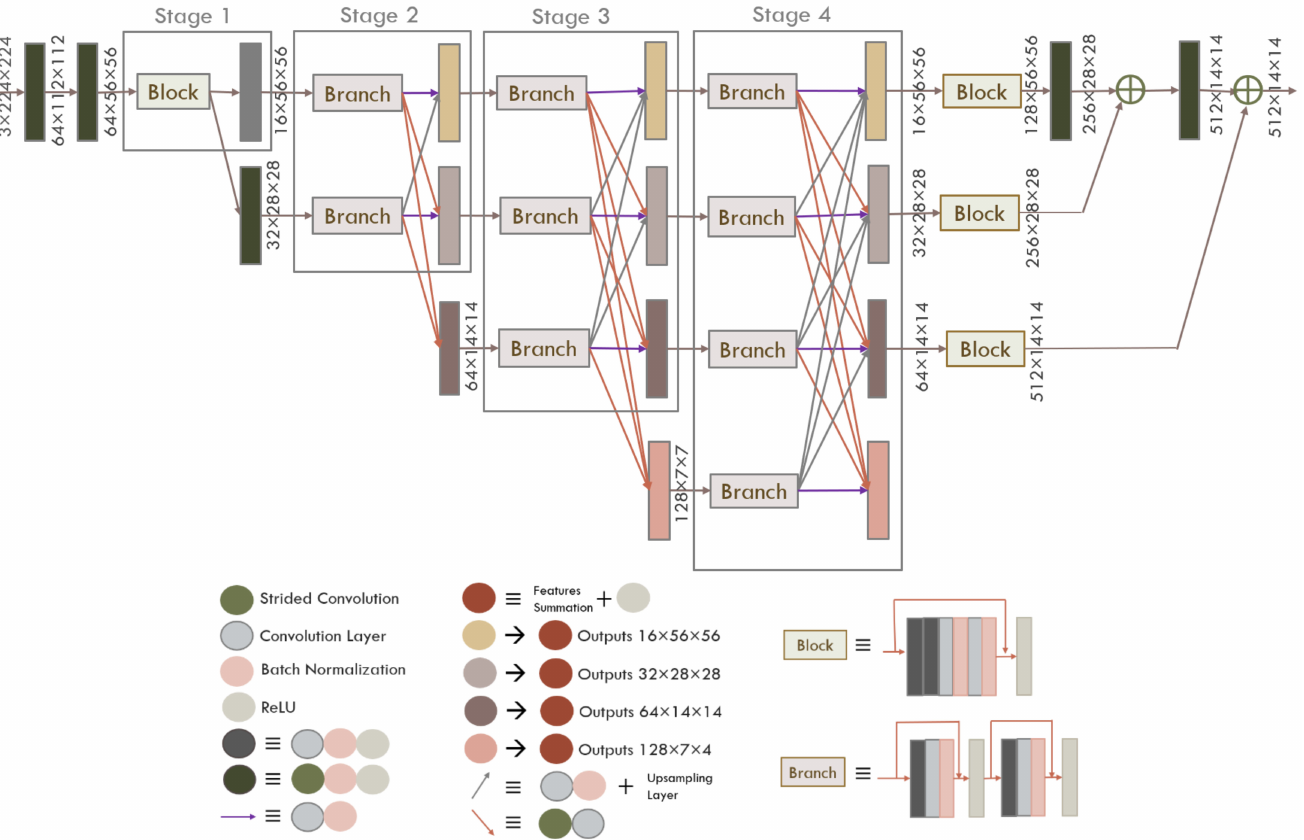
Figure 5. High-Resolution Network (HRNet)